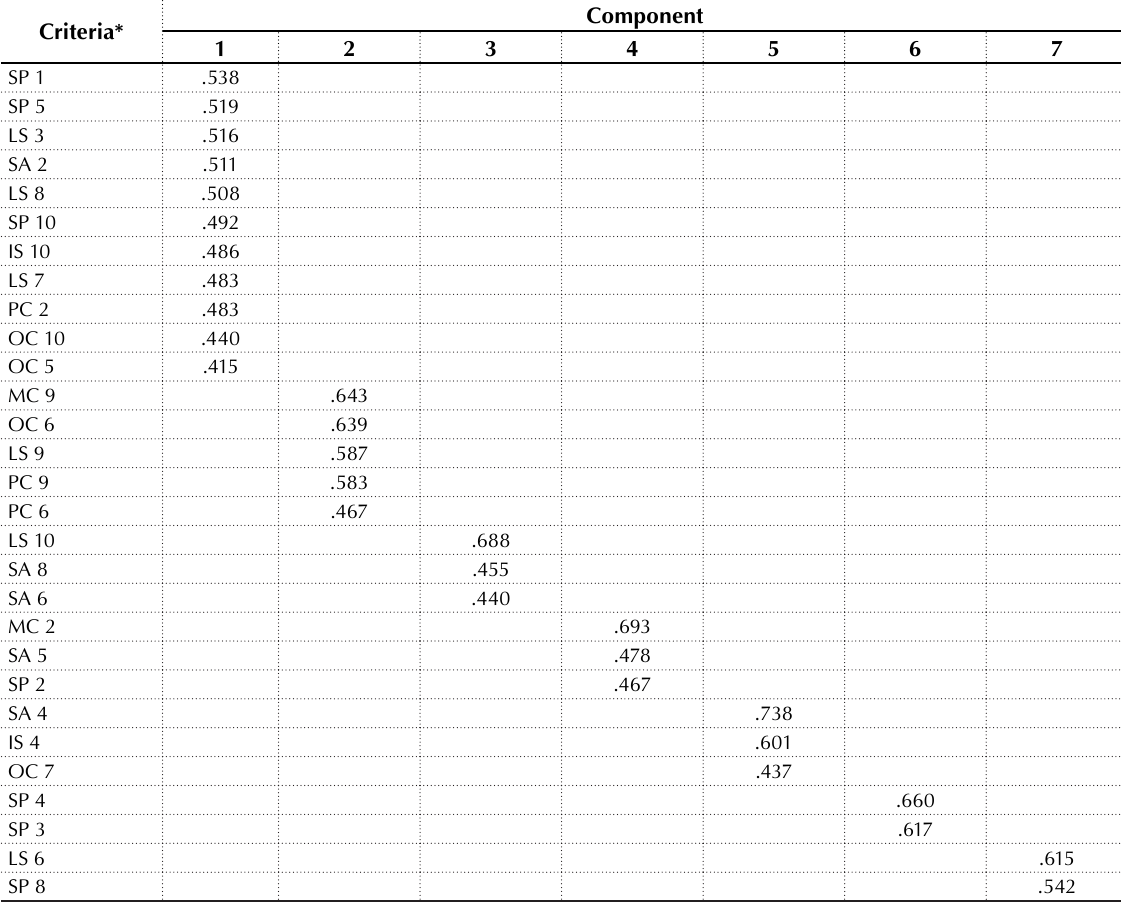
Table 6 (cont). Rotated Component Matrix: Sub-factors extracted from Factor 1 Criteria*